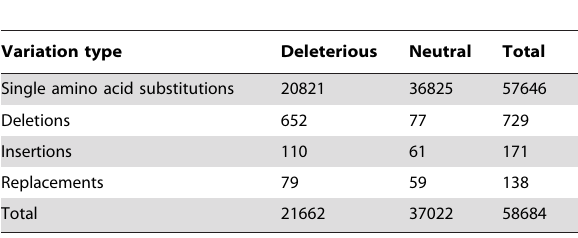
Table 1. Number of human protein variations collected from the UniProt/Swiss-Prot